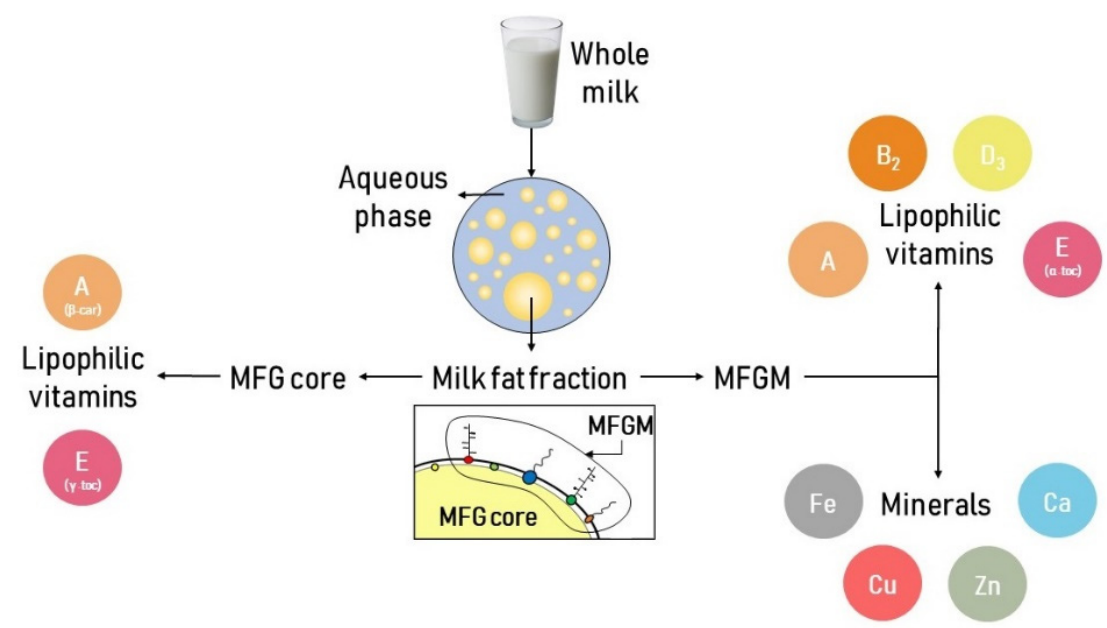
Figure 2. Schematic representation of the major minerals and lipophilic vitamins present in the milk lipid fraction.